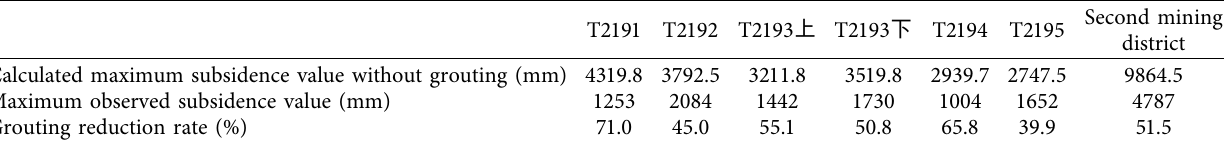
Table 8: Calculation table of the subsidence reduction rate in the second mining